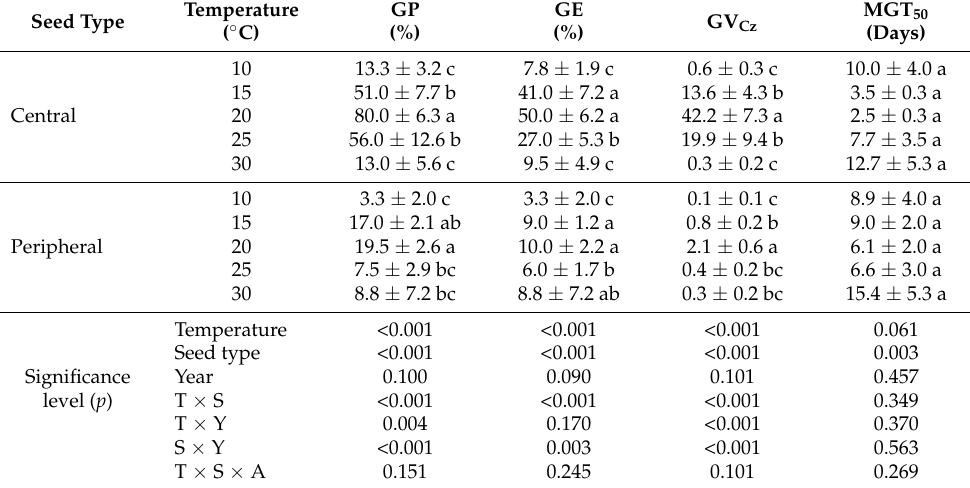
Table 2. Mean values ( ± SE) and statistical significance of the germination parameters assessed at different temperatures, in the lab under white light. Averages for seeds collected in June 2005 and June 2006 are shown as a whole.